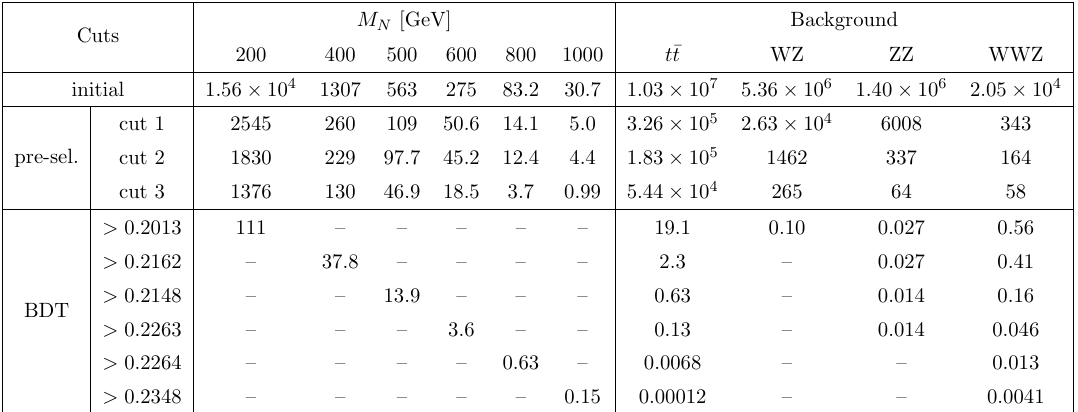
Table 1 . Numbers of events at each cut stage for signals with (cid:12)xed j V lN j 2 = 10 (cid:0) 2 and di(cid:11)erent sterile neutrino masses M N and for background processes. The numbers correspond to an integrated luminosity of 3 ab (cid:0) 1 at the HL-LHC.